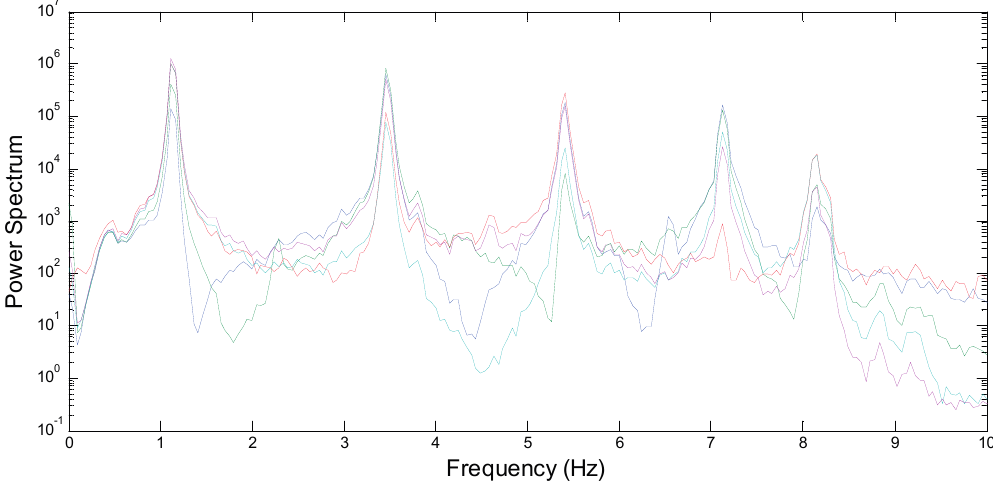
Figure 7. Power spectra of measured acceleration responses.